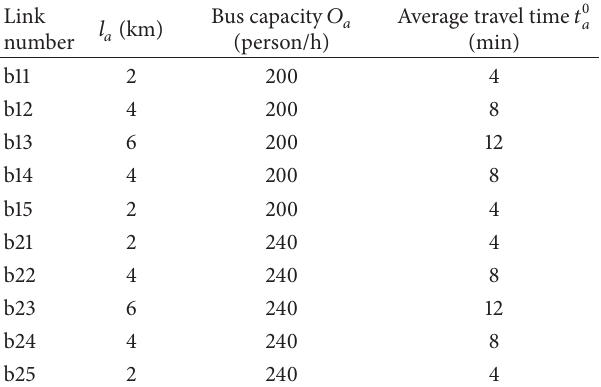
Table 2: Physical properties of bus network.